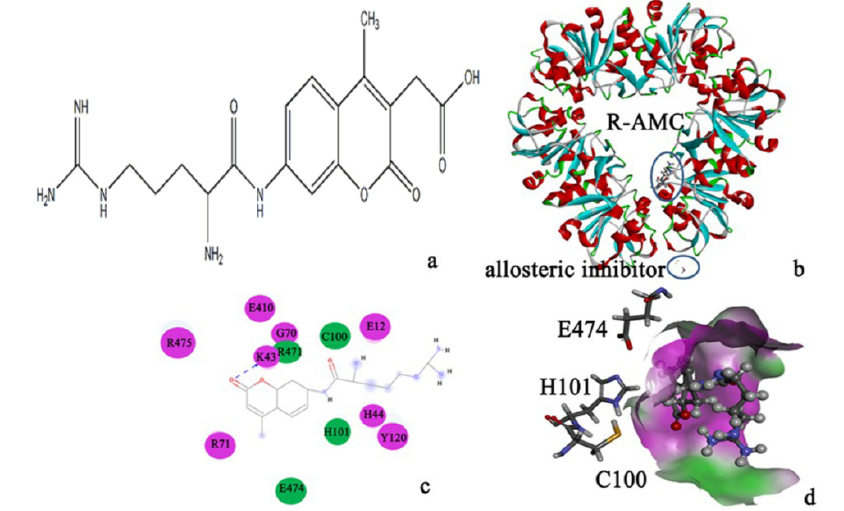
Figure 4. ( a ) R-AMC; ( b ) The docked complex; R-AMC located in the AC contacts; ( c ) The important residues in R-AMC binding calculated by Discovery studio 3.5 client. Color green represents for van der Waals contacts with R-AMC, and color purple represents for electrostatic contacts with R-AMC; ( d ) The surface around the R-AMC generated by Discovery studio 3.5 client. R-AMC is in the active pocket and near the active triad (C100, H101 and